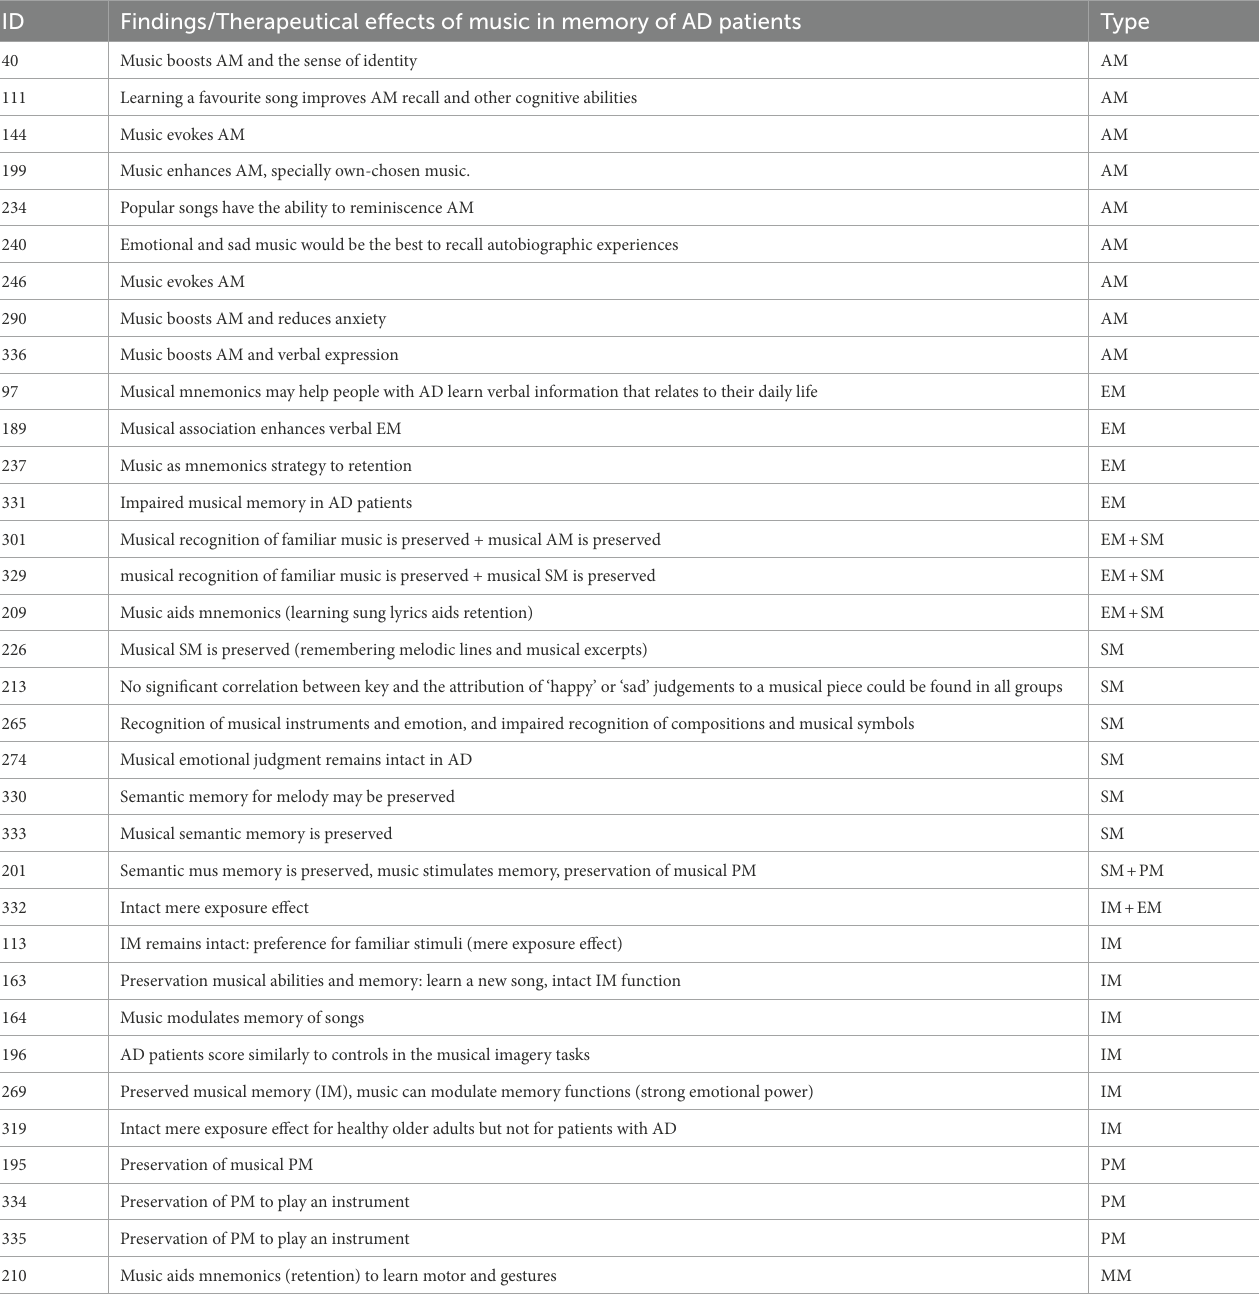
TABLE 1 Effects of music on different types of memory as recorded in the literature. ID Findings/Therapeutical effects of music in memory of AD